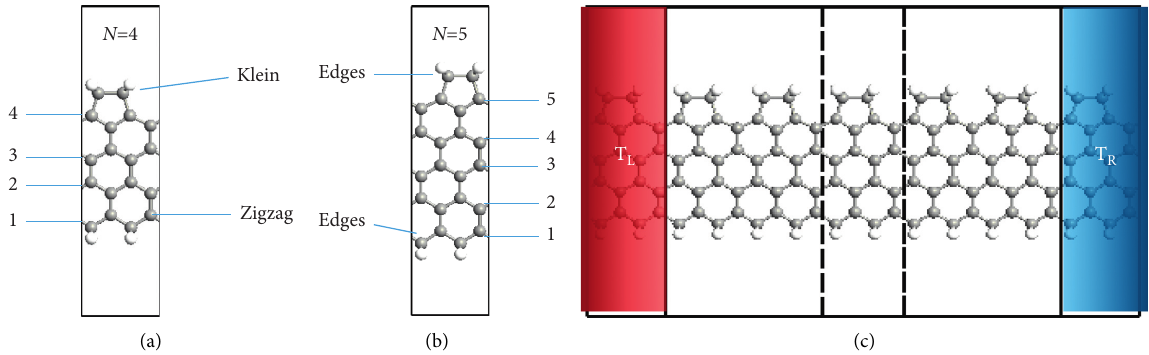
Figure 1: (a, b) Optimal structure of the N-ZKGNRs (say N � 4, 5), in which carbon and hydrogen atoms are described by the silver and white balls, respectively. (c) Schematic description of the thermal spin device using N-ZKGNRs (say N � 4).